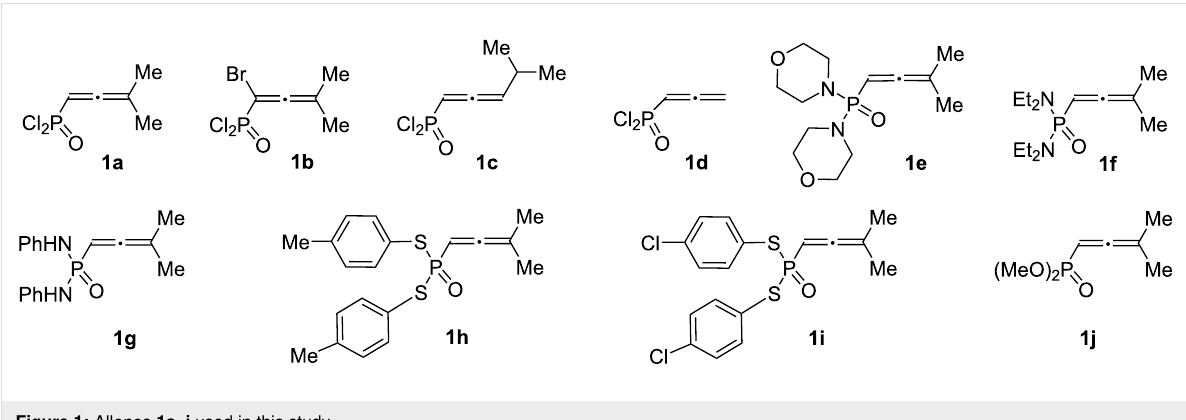
Figure 1: Allenes 1a–j used in this